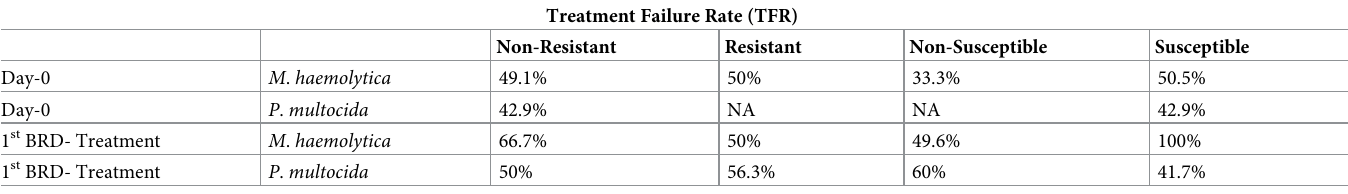
Table 3. High-risk feeder heifer treatment failure rate by bacterial species and clsi tulathrymycin susceptibility classification.